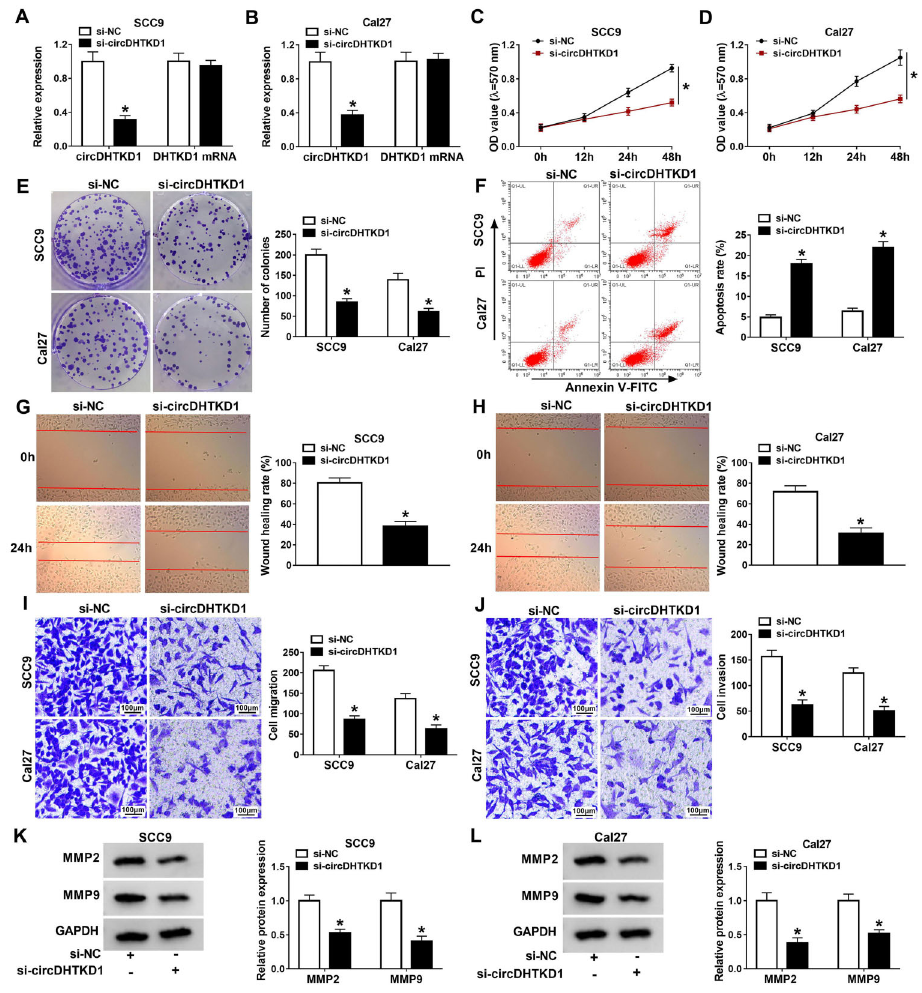
Figure 2. Silencing circDHTKD1 suppressed cell growth and metastasis and induced apoptosis of oral squamous cell carcinoma (OSCC) cells. SCC9 and Cal27 cells were transfected with si-NC (negative control) or si-circDHTKD1. A and B , The levels of circDHTKD1 and DHTKD1 mRNA were assayed by qRT-PCR. MTTand colony formation assays were, respectively, used for analyzing cell viability ( C and D ) and clonal ability ( E ). F , Apoptosis was measured by fl ow cytometry. G and H , Wound healing assay was carried out to assess cell migration ability. Transwell assay was used for analyzing cell migration ( I ) and invasion ( J ) (scale bar: 100 m m). K and L , The protein levels of MMP2 and MMP9 were detected using western blot. Three biological and three technical replicates